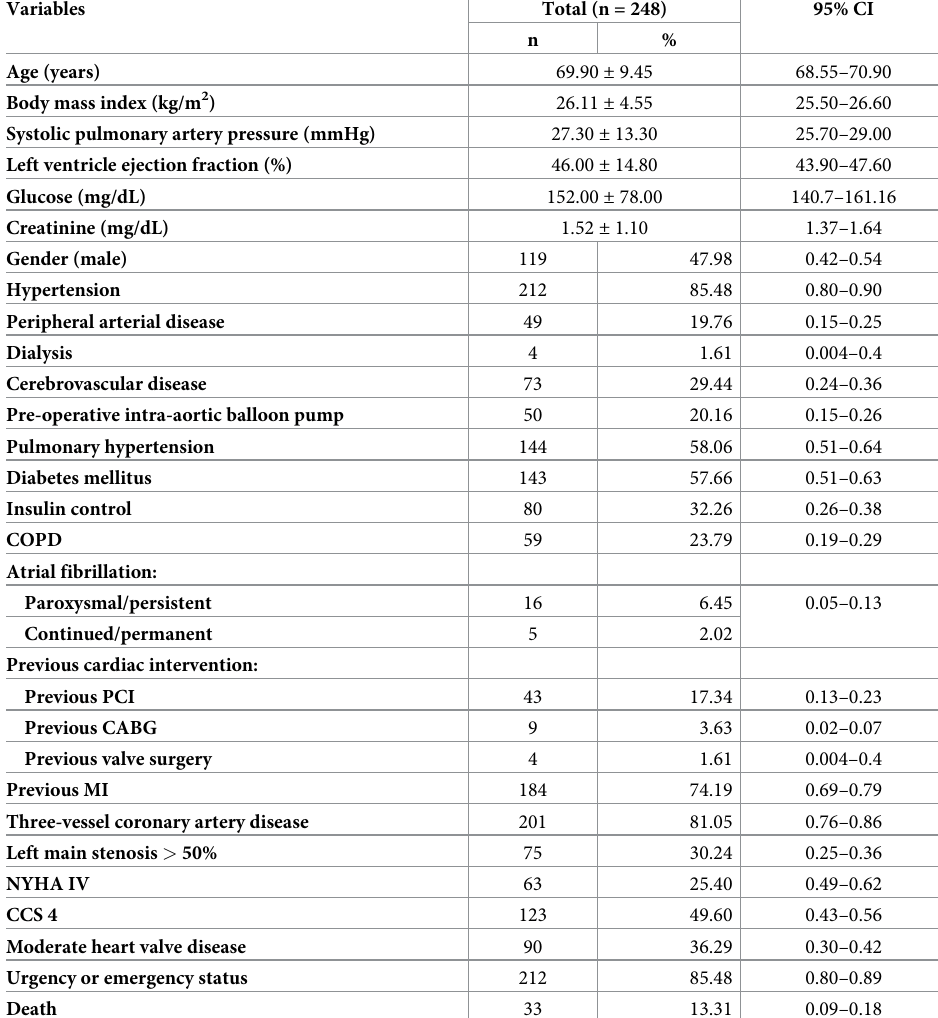
Table 1. Description of variables used in high-risk CABG